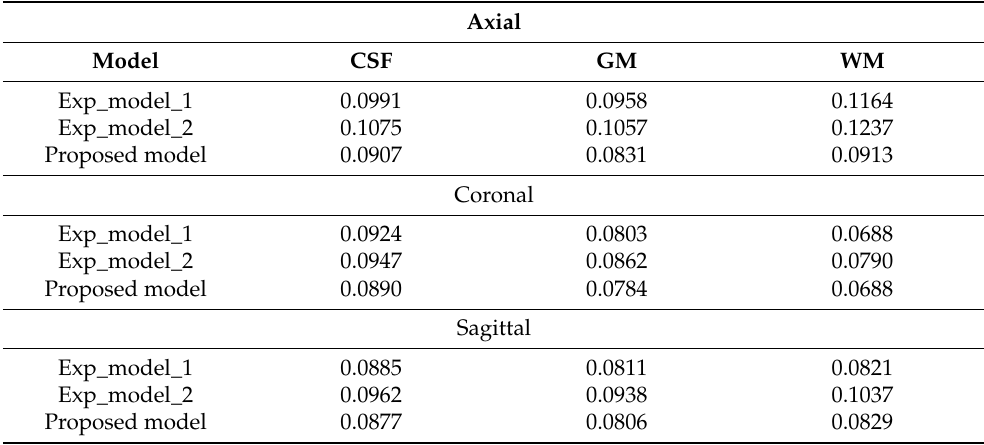
Table 1. VOE comparison of segmentation results from different experimental models.